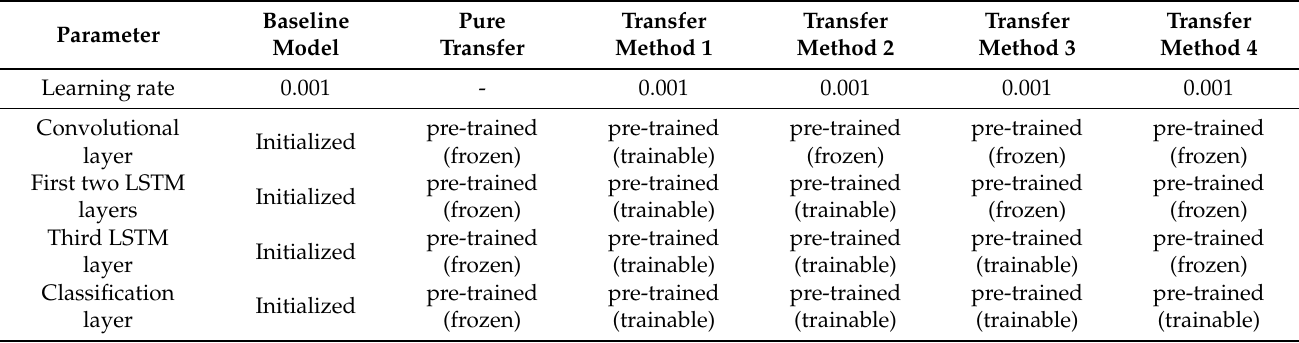
Table 1. Models used in this study and their characteristics. The baseline model is a model trained from scratch, where all layers are initialized, pure transfer is a source model used without retraining on a target dataset. Transfer methods 1, 2, 3 and 4 are a combination of frozen and trainable pre-trained transferred layers.